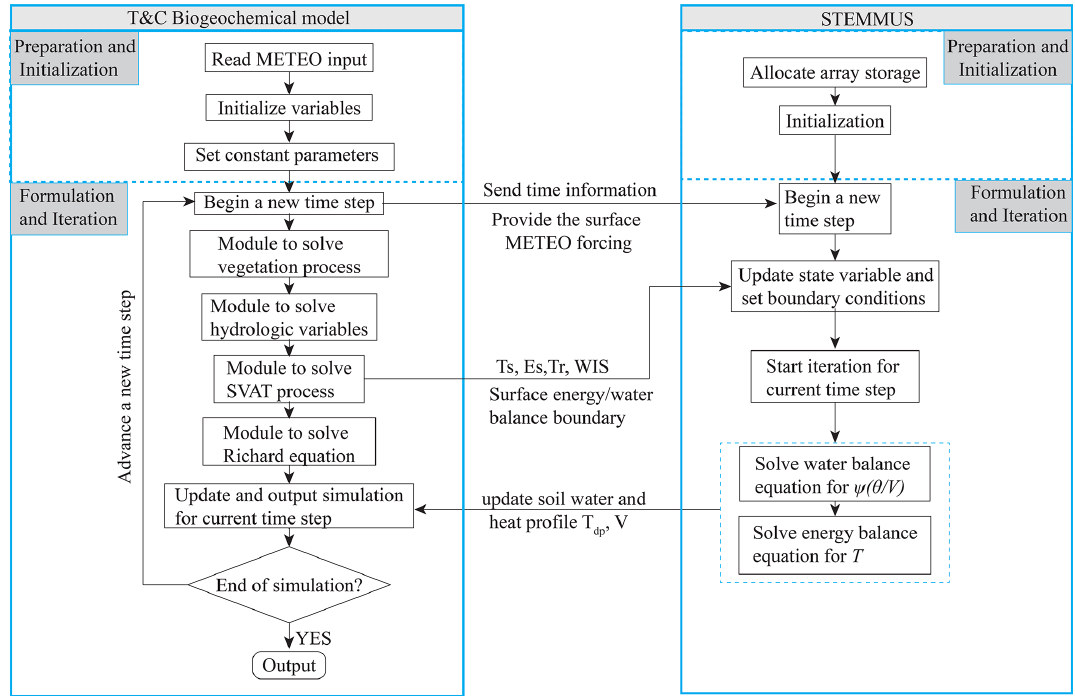
Figure 3. Coupling procedure of the STEMMUS and T&C models. METEO is the meteorology forcing, and SVAT is acronym for the soil–vegetation–atmosphere mass and heat transfer. Ts, Es, Tr, and WIS are the surface temperature, soil evaporation, plant transpiration, and incoming water flux to the soil, respectively. T dp and V are the soil profiles of temperature (in ◦ C) and liquid water volume in each layer